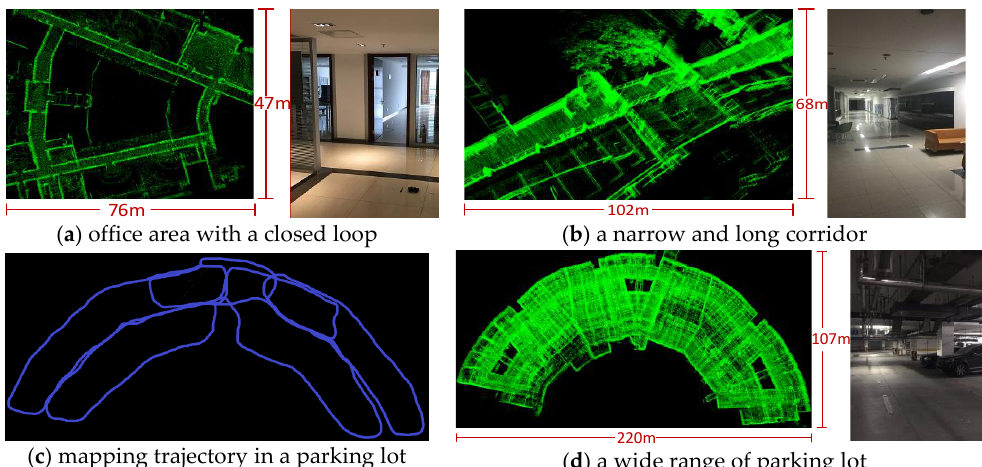
Figure 5. The maps generated in the indoor and outdoor environments.